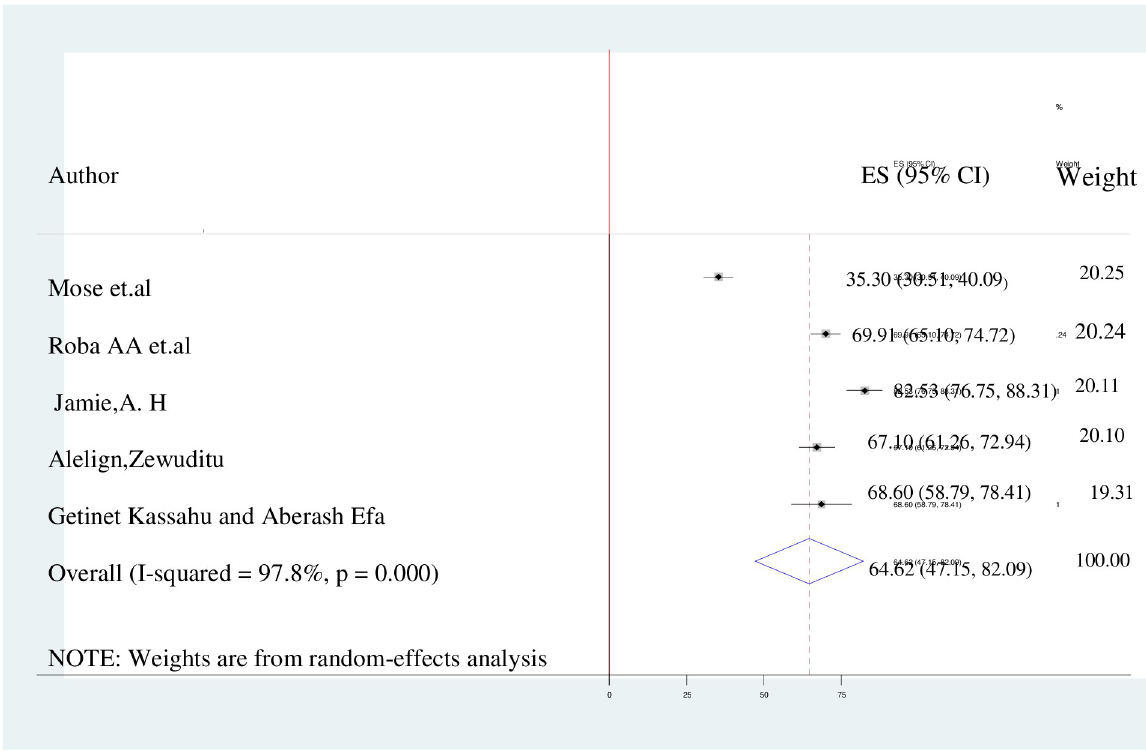
Fig 2. Forest plot of knowledge with the height of the diamond is the overall effect size (64.62% while the width is the confidence interval at 95% (47.15%–82.09%). The y-axis shows the standard error of each study while the x-axis the estimate of effect size of the each study. The vertical line denotes the no effect. The box represents the effect size of each study and the line across the box is confidence interval of each